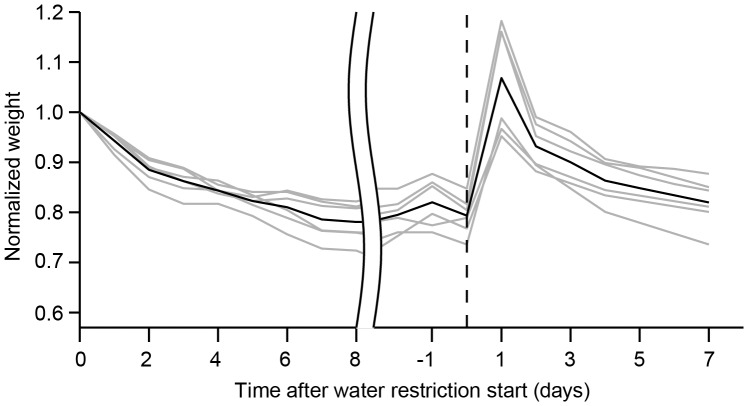
Normalized weight of 5 female mice after the initial water restriction (left) and after one day of free access to water (dotted line, day 0).